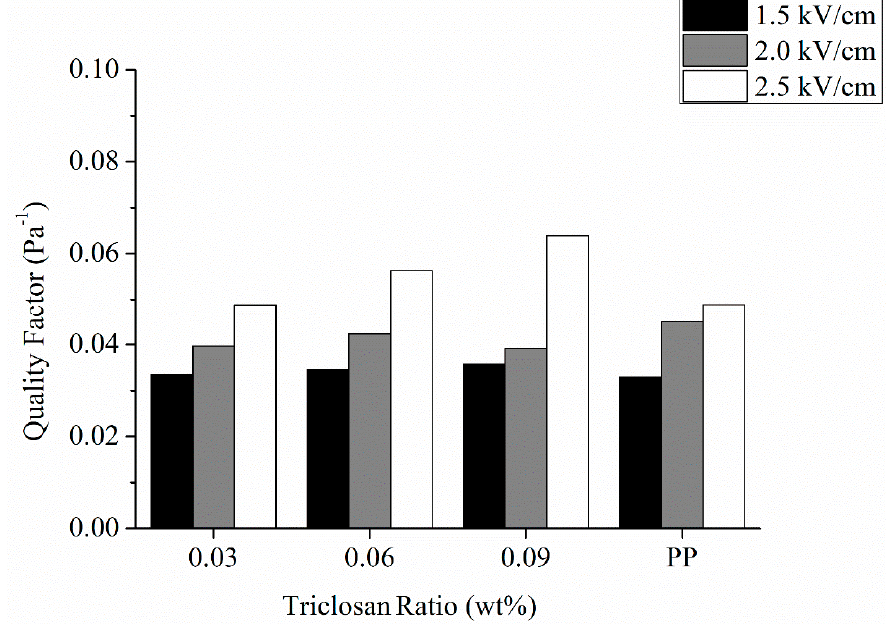
Figure 8. Quality factor of antibacterial electret PP filters as related to triclosan amount (0.03, 0.06,